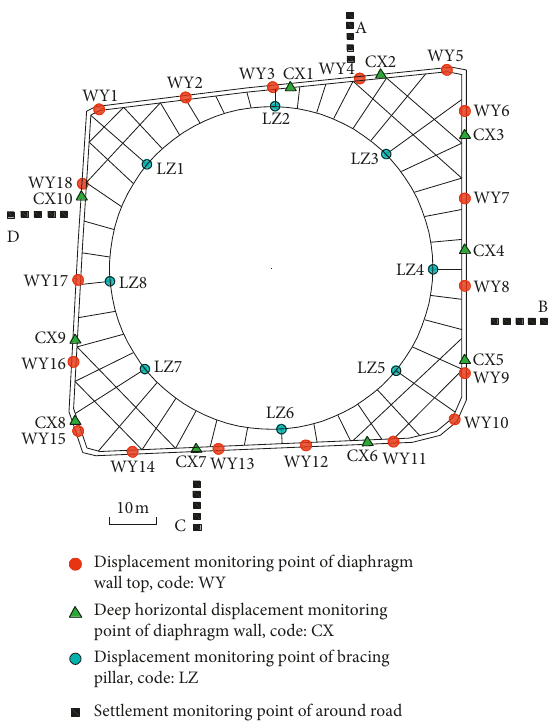
Figure 4: Instrumentation layout of the excavation in plane for field